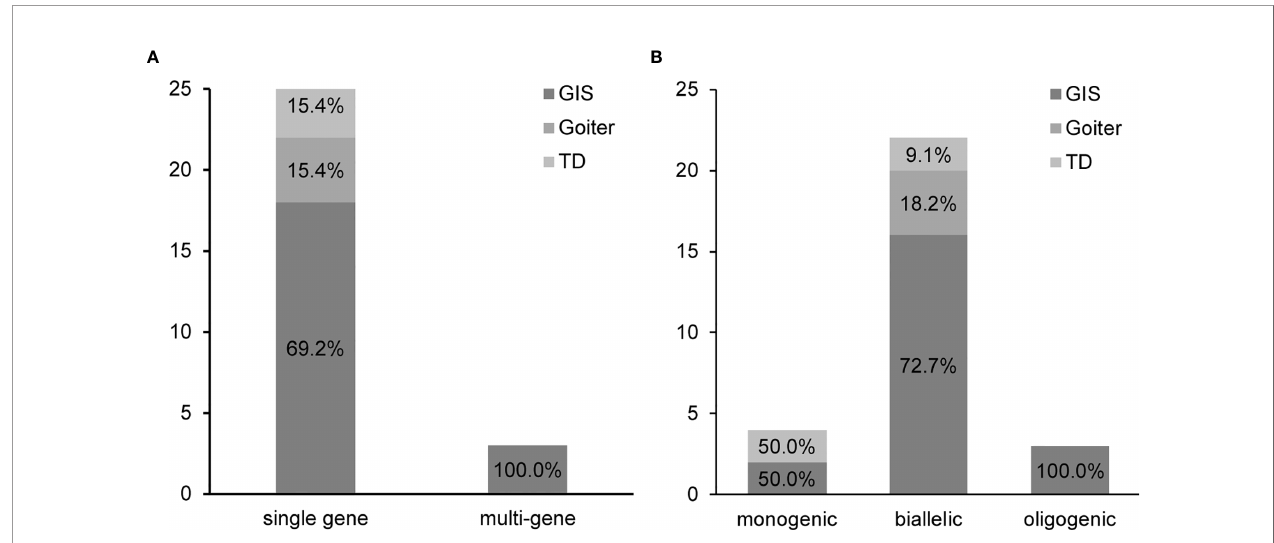
FIGURE 2 | Grouping of 29 patients with congenital hypothyroidism (CH) causative variants. (A) Patients were divided into a single-gene and a multi-gene group. (B) Patients were classi fi ed into a monoallelic, a biallelic, and an oligogenic group. GIS , gland - in-situ; TD , thyroid